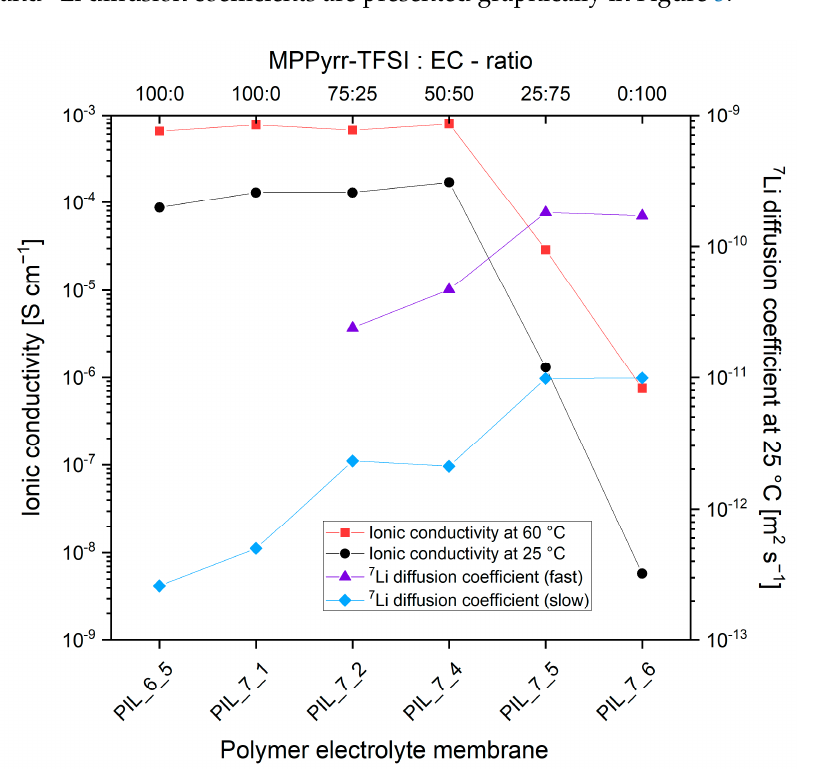
The influence of the liquid electrolyte composition on the ionic conductivity values and 7 Li diffusion coefficients are presented graphically in Figure 5.